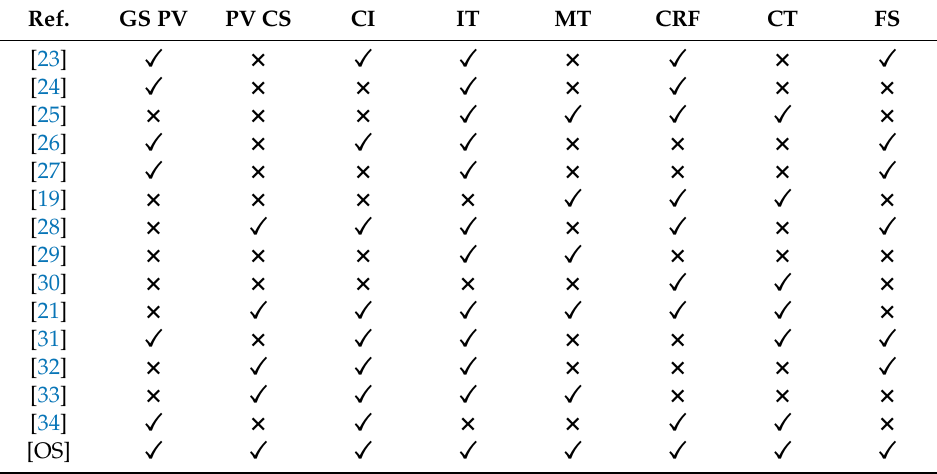
Table 1. Comparative analysis of state-of-art literature